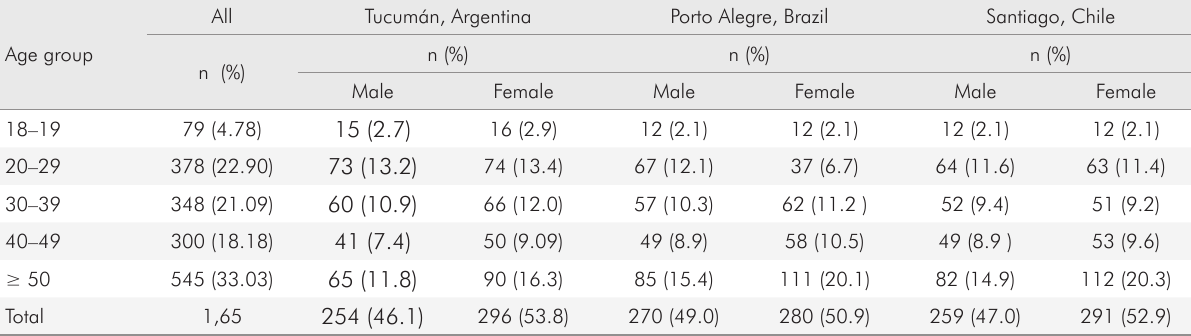
Table 1. Study population/sample by city, age, and gender. n = 550. Age group